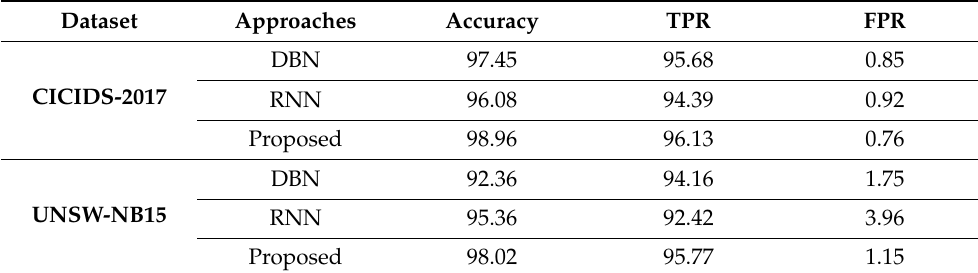
Table 10. Comparison of the test results with various approaches. Dataset